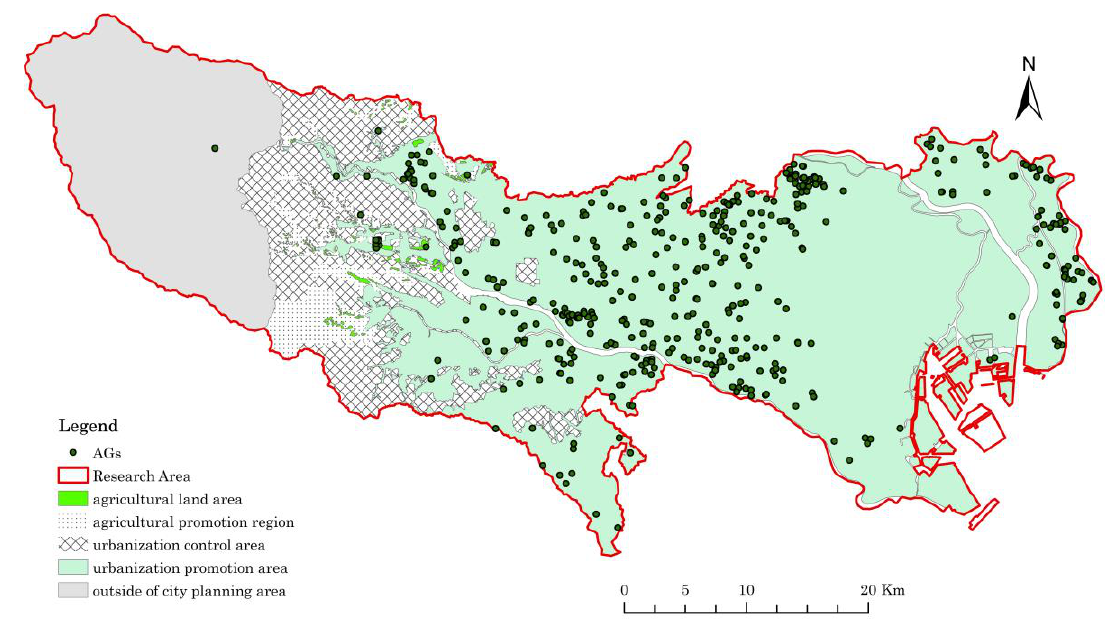
Figure 4. Land use of city planning and AG locations in Tokyo.